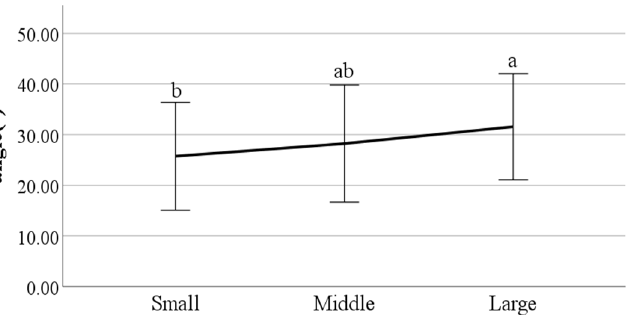
Figure 34. Head movements in the sagittal plane at heel-strike (F value: 4.13, DF: 2, p -value: 0.02).